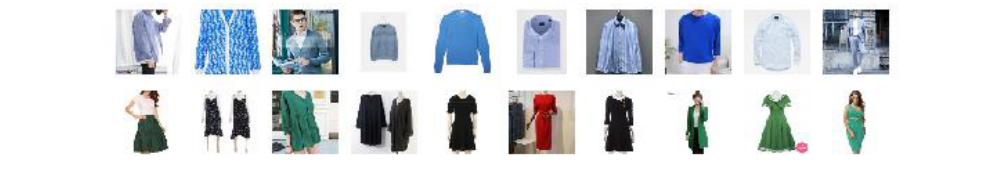
Figure 11. Search results obtained using pseudo-SQL queries.